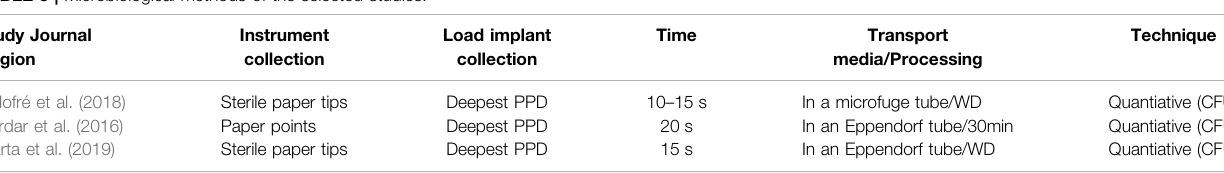
TABLE 3 | Microbiological methods of the selected